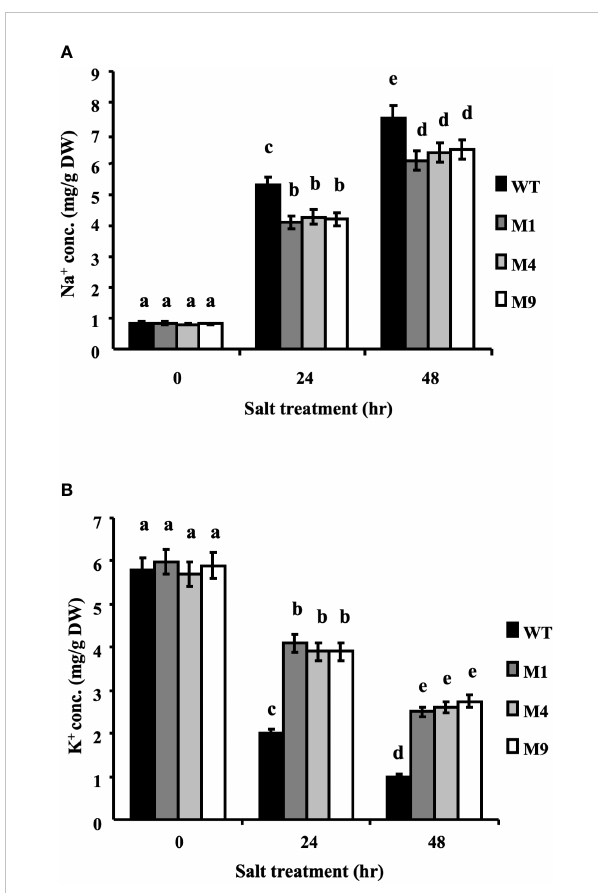
FIGURE 7 Transgenic AtMSRB5 rice accumulated fewer sodium ions. Sixty- day-old seedlings were treated with 250 mM NaCl for 0, 24 and 48 h. Samples were rinsed with distilled water, dried, and collected. The endogenous (A) Na + ion and (B) K + ion contents were determined. Data are means ± SD ( n = 3) of 3 independent experiments and analyzed statistically using Duncan ’ s test. Letters indicate signi fi cant differences at P <